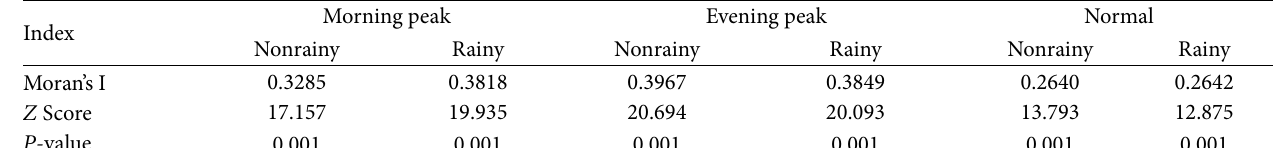
Table 1: Global Moran’s I summary for specific periods.